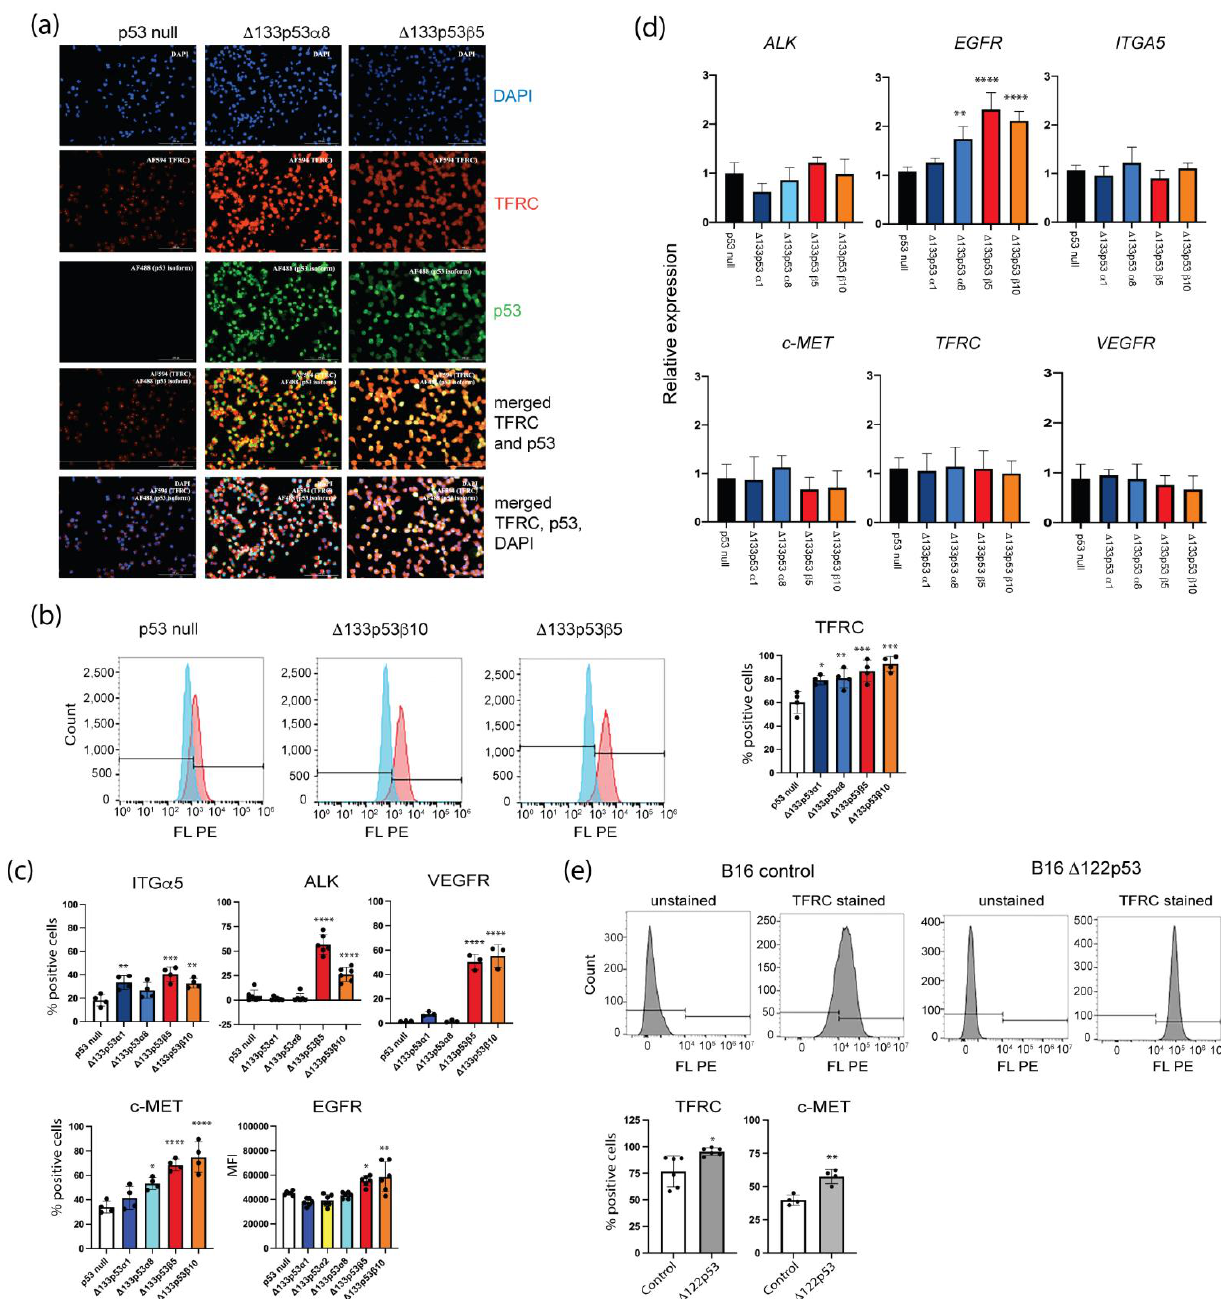
Figure 7. Cancer-promoting proteins increased on the Δ 133p53 α and Δ 133p53 β cell surface. ( a ) Increased TFRC staining in Δ 133p53 cells using immunofluorescence. Scale bar 200 µm. ( b ) Flow cytometry to identify the transferrin receptor (TFRC) on the cell surface. Left: histogram for TFRC staining, with unstained cells in blue and stained cells in red. Right: quantification of TFRC amongst Δ 133p53 α and Δ 133p53 β cell lines. ( c ) Flow cytometry to compare the presence of other cancer-promoting proteins on the Δ 133p53 cell surface. ( d ) Most proteins that increased on the 133p53 α and Δ 133p53 β surface were not explained by altered gene expression using real-time quantitative PCR. ( e ) Flow cytometry to identify TFRC and c-Met on the cell surface of murine B16 melanoma cells expressing a mimic of Δ 133p53 α ( Δ 122p53) or the control vector (B16 control). Top: histogram for TFRC staining. Bottom: quantification of TFRC and C-Met. Results are relative to the expression in the p53 null cell line. Results: mean ± s.d. from at least three replicates. * p < 0.05, ** p < 0.01, *** p < 0.001, **** p < 0.0001. Black dots, individual results.